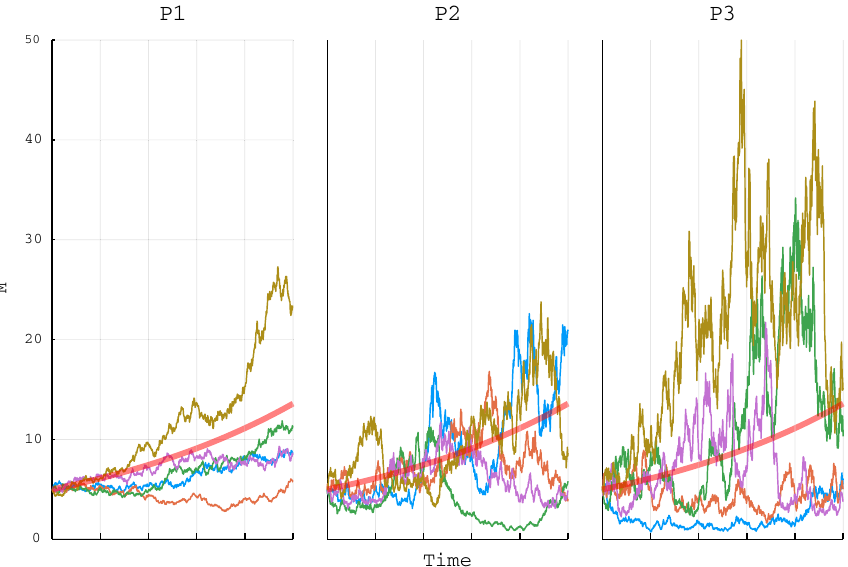
Figure 2. The figure demonstrates three different (P1–P3) scenarios for the stochastic Luria–Delbrück model, each realised 5 times, showing the mean number of mutations M t (ω) (vertical axis) in a population at time t (horizontal axis). All parameters are the same for all scenarios ( P 0 = 1 , µ = 5 , k = 1 and T = 1 ) except for p that determines the influence of the random term. Panel P1: p = line designates the Luria–Delbrück model without the Brownian motion